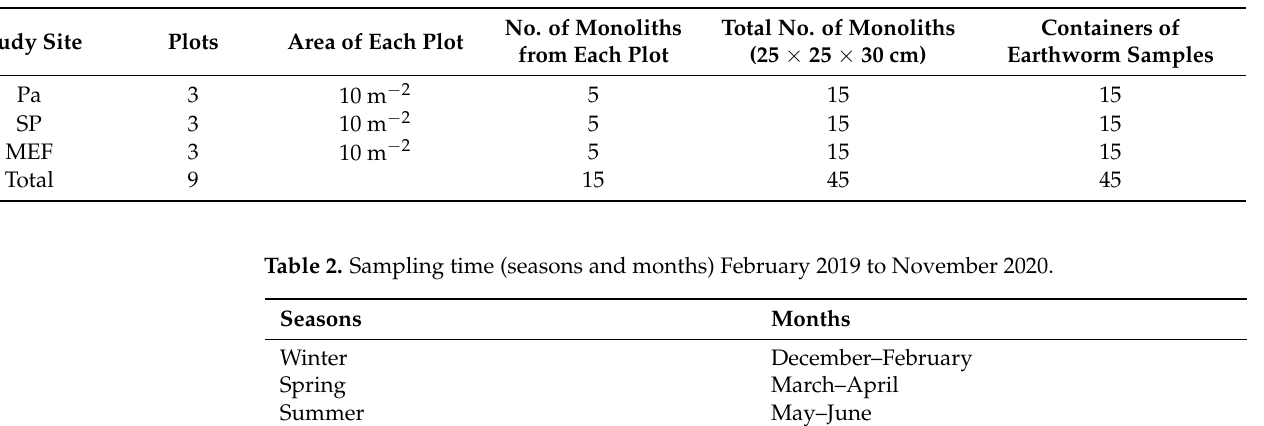
Table 1. Design of sampling site allocation during each sampling time (2019–2020).